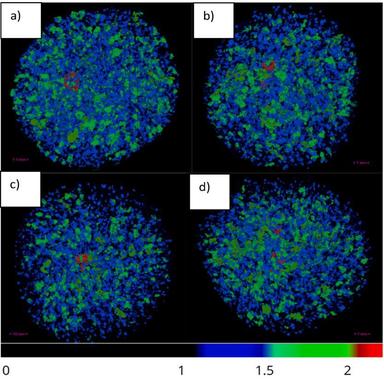
Slice image (orthographic view) of (a) CER-1, (b) CER-2, (c) CER-3, (d) CER-4, 3D-pore shape of the material.